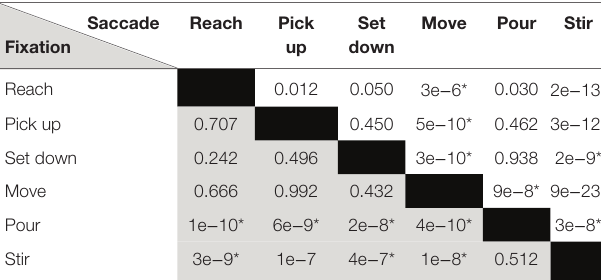
TaBle 2 | The lower left triangle of the table (shaded in gray) summarizes p -values for t -tests of average normalized gaze fixation duration for different pairs of action unit verbs while the upper right triangle represents p -values for t -tests with regards to saccade size.